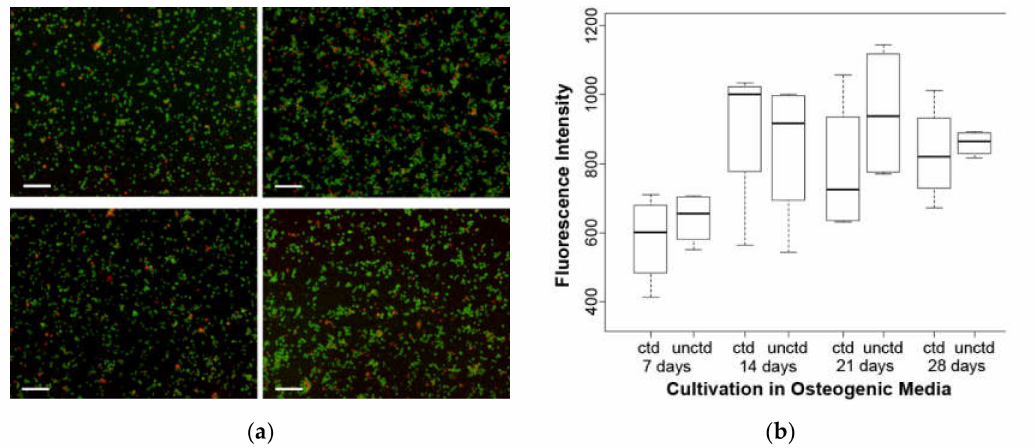
Figure 4. Propidium iodide: ( a ) To visualize the proportion between dead (red) and living (green) cells, cells were photographed after counterstaining them with Calcein-AM, Sigma C1359 (not part of the experiment). Top row: coated, 14 and 28 days. Bottom row: uncoated, 14 and 28 days; bar = 200 µ m. ( b ) No statistically significant di ff erences between the two materials are evident. ctd—coated;